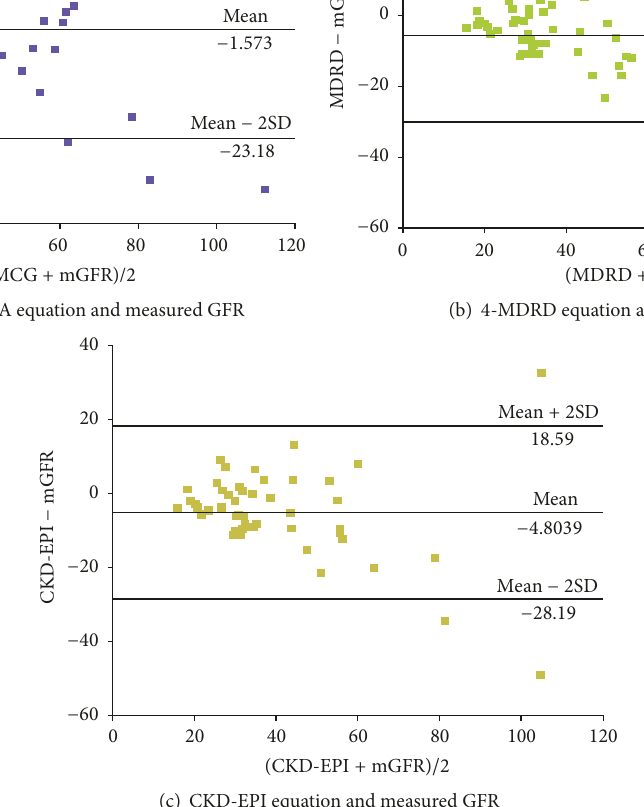
Figure 1: (a–c) Bland and Altman analysis of GFR estimates. In this analysis, the differences between estimated and measured GFR are plotted against the average of the estimated and measured GFR for each individual